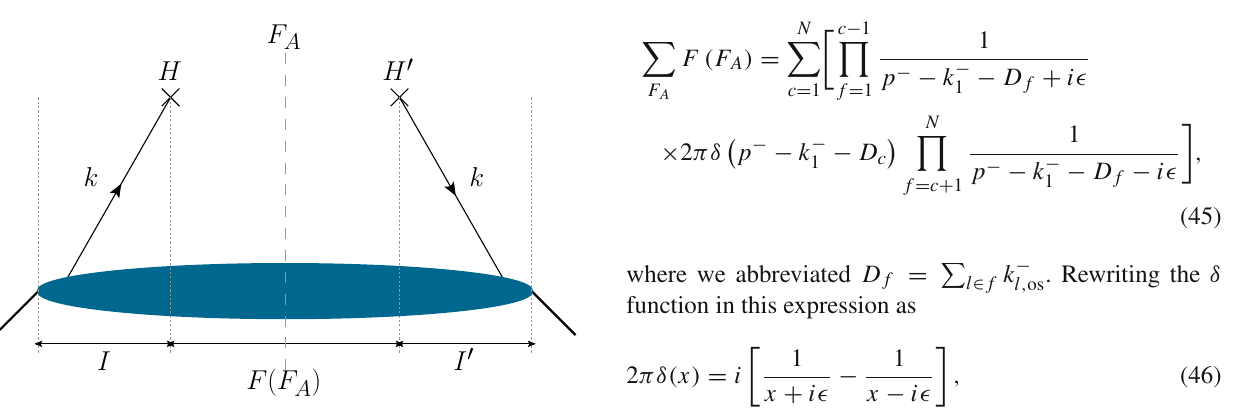
Fig. 6 Schematic illustration of an LCPT graph for a PDF. H ( H (cid:6) ) denotes the light-cone time of the vertex for the insertion of the twist- two operator on the left (right) of the final-state cut. Since the order of vertices matters for evaluating LCPT graphs, one cannot place that operator insertion on the line indicating the final state cut, as was done for the Feynman graphs in Sect.